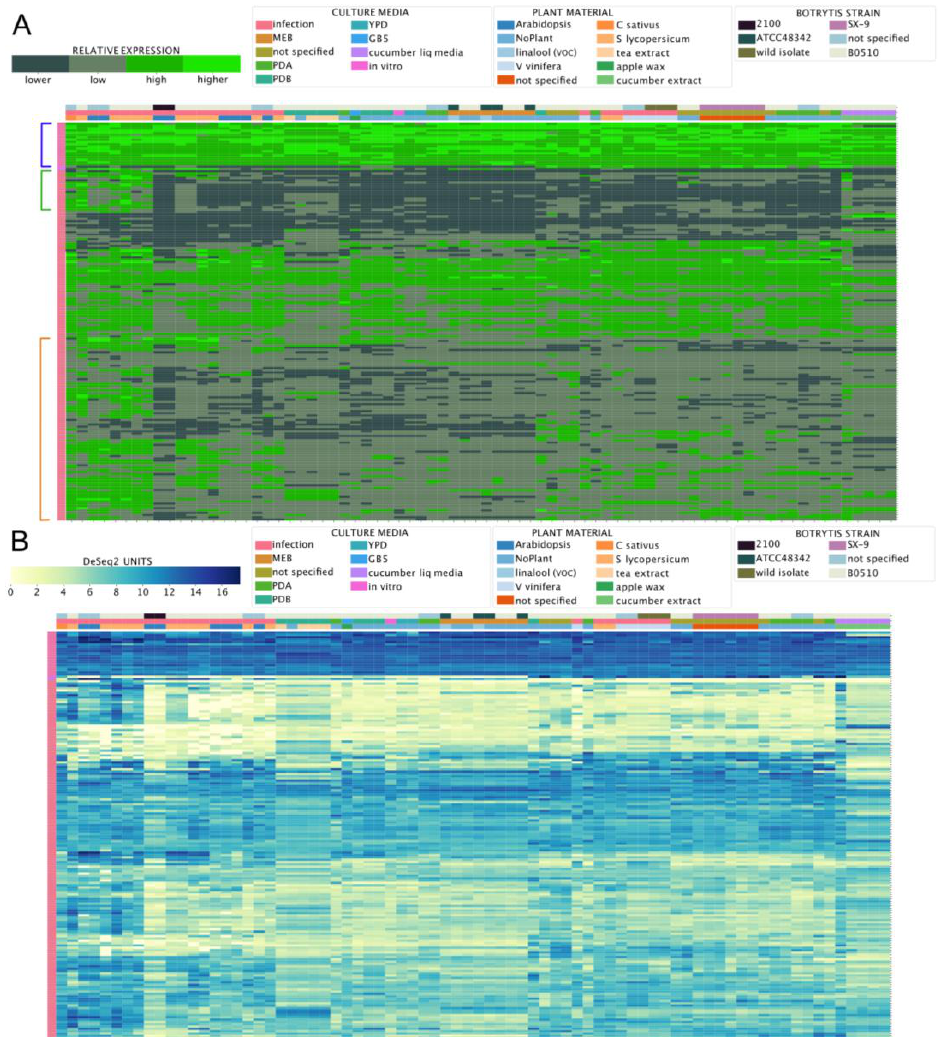
Figure 7. mRNA levels of virulence factors detected in proteomics studies. ( A ) A heatmap depicting the transcript levels of 176 protein-encoding genes whose products were detected in proteomics studies, as determined using the BEB quartile-categorized expression option (lower: dark green; higher: light green) or the continuous color scale ( B ) from low to high expression (yellow to dark blue). Owing to the number of genes being analyzed, neither culture conditions nor gene IDs are included in the figure (see Supplementary Material 5). In ( A ), genes with high and stable patterns of expression across conditions are indicated with a blue square bracket, while two groups of genes displaying an in planta “induced” pattern of expression are indicated with green and orange square brackets.